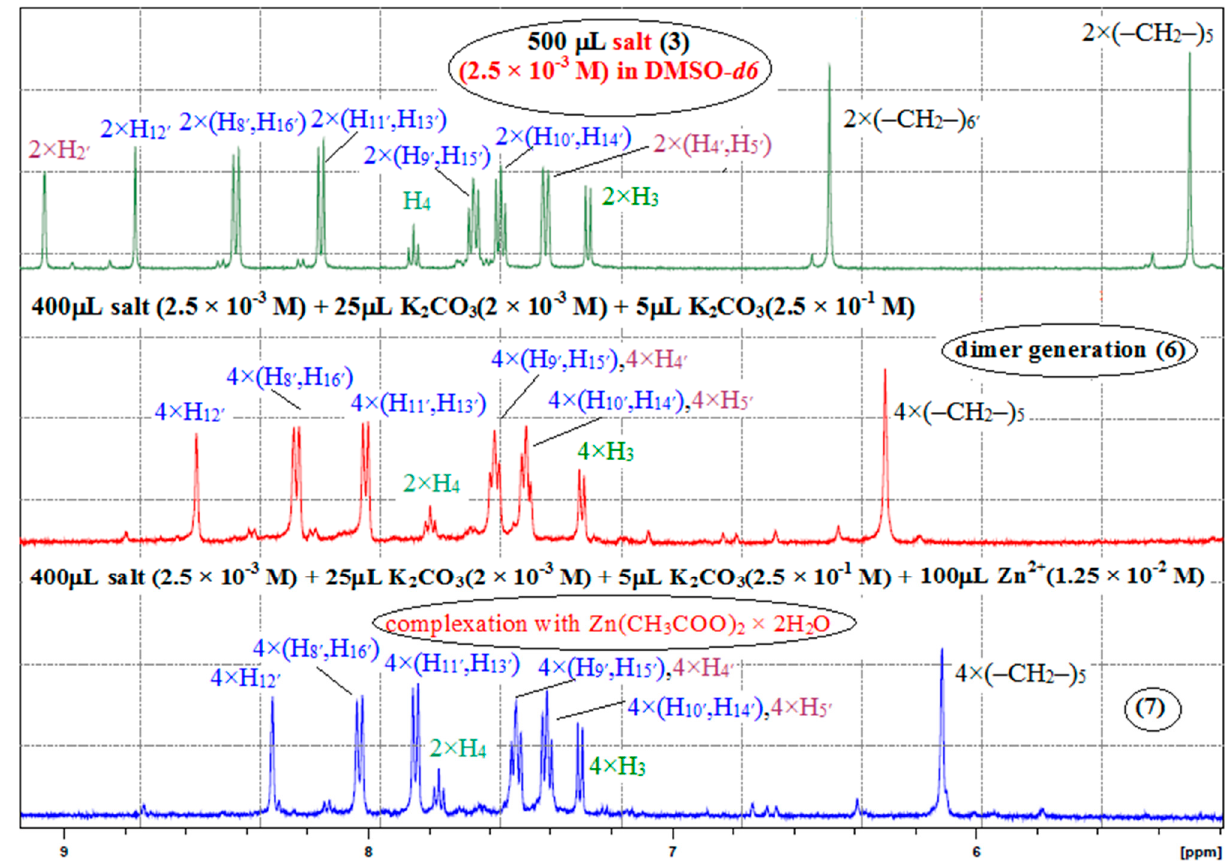
Figure 1. The 1 H-NMR spectra of salt 3 , dimeric structure 6 and dimeric complex 7